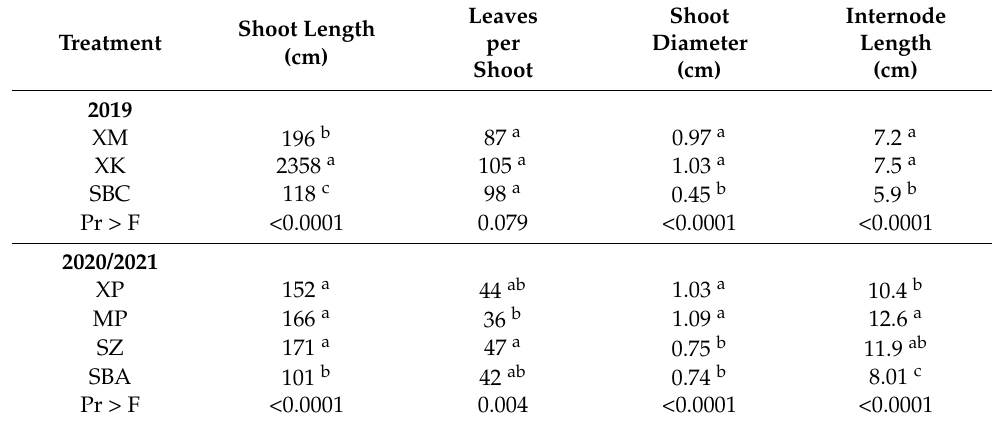
Table 4. Vine growth assessments at flowering for all varieties in potted trials in season 2019